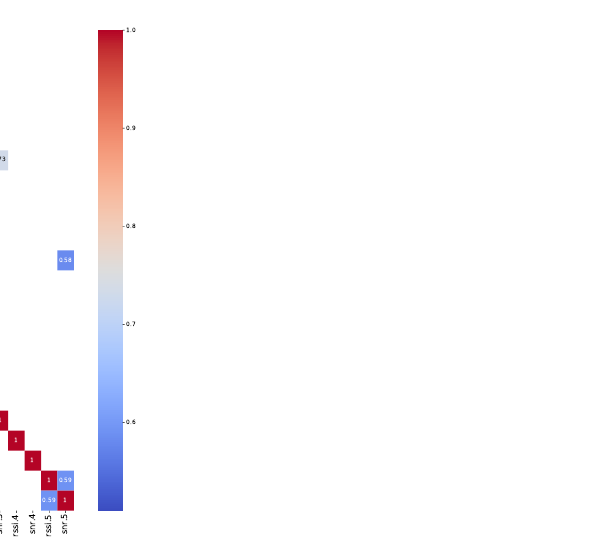
Figure 9. Data correlation for RSSI and SNR values for ROOM A509 and location points 9 and 11.